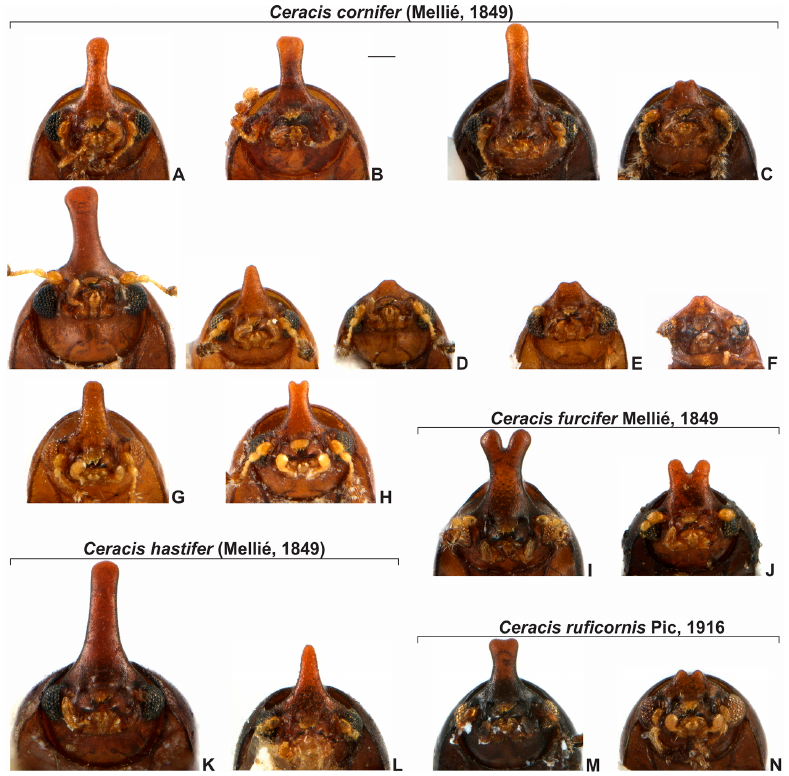
Figure 5. Male morphs of species of the furcifer group from different localities. A–H Ceracis cornifer (Mellié), ( A ) lectotype from Brazil, ( B ) Florida, United States of America, ( C ) Urubici, SC, Brazil, ( D ) Juiz de Fora, MG, Brazil, ( E,F ) Jequeri, MG, Brazil, ( G ) São Francisco de Paula, RS, Brazil, ( H ) Tucuman, Argentina. I,J Ceracis furcifer Mellié, ( I ) Paranhos, MS, Brazil, ( J ) Colombia. K,L , Ceracis hastifer (Mellié), ( K ) lectotype from Colombia, ( L ) Colombia. M,N Ceracis ruficornis Pic, ( M ) Peruíbe, SP, Brazil, ( N ) Ilha dos Búzios, SP, Brazil. Scale bar: 0.1 mm.